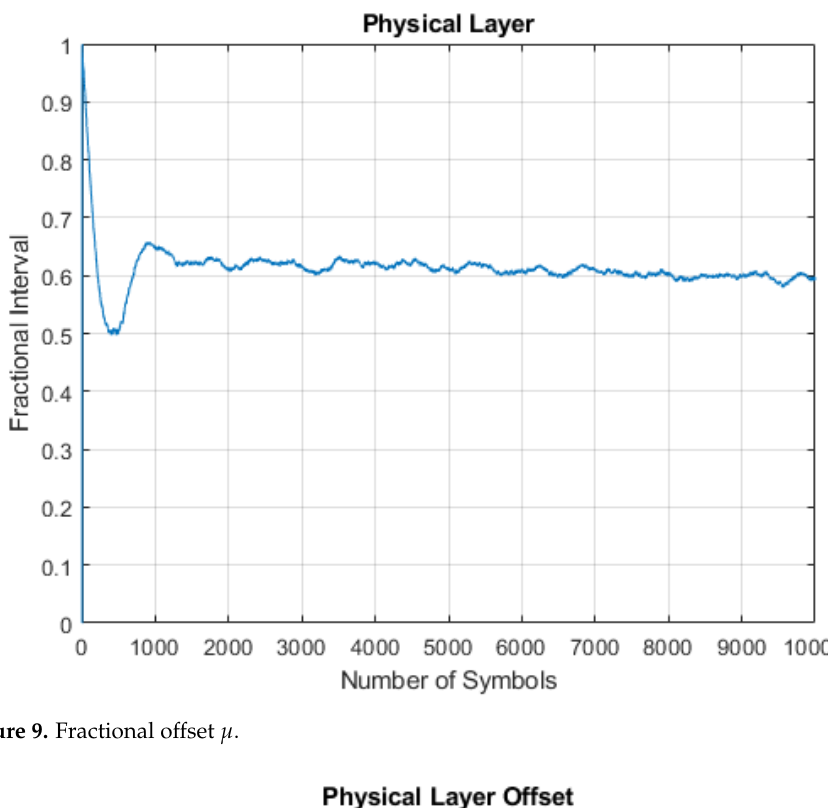
Figure 9. Fractional offset µ .